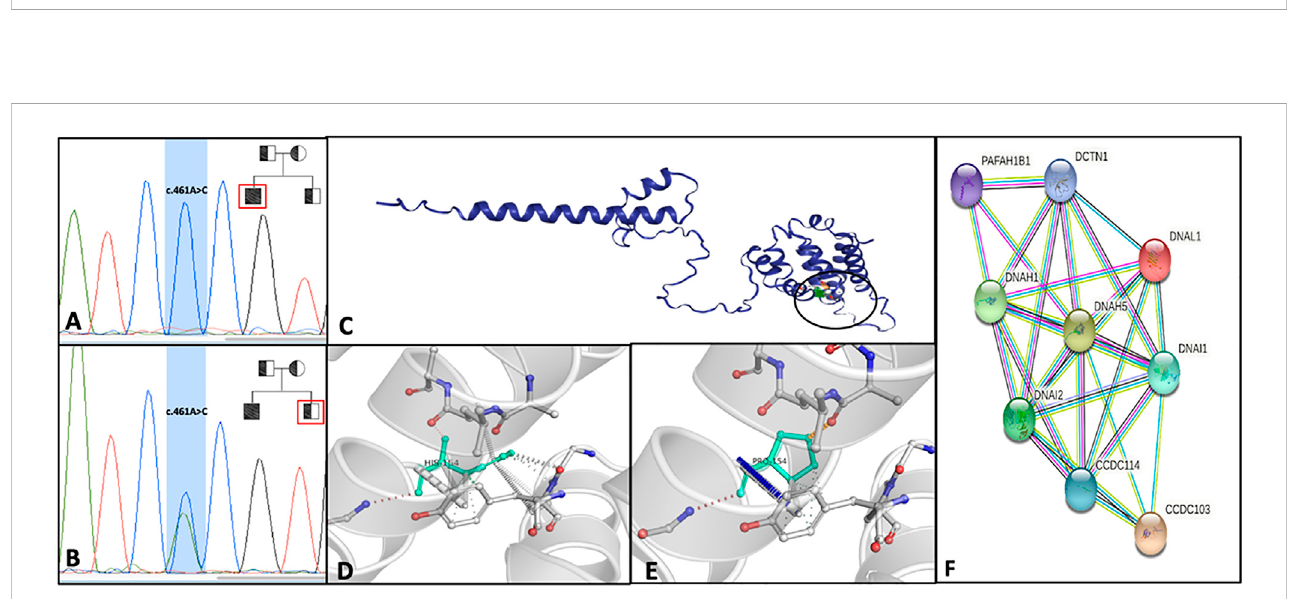
FIGURE 1 Electron microscopy micrographs of different section levels of the spermatozoa fl agellum with a focus on IDA and ODA (A – C) , spermatozoa samples treatedwithtannicacid (D,E), andnasalmucosasamples (G – L) .ScalebarforA-B-C100 nm,D-E-H-I50 nm,F500 nm,andG200 nm.Immuno fl uorescence (F) oftheejaculatedspermrevealedtheabsenceofbothDNAH1andDNAH5inthepatient(red)comparedtothenormalcontrol.Ananti-tubulinantibodywas used to mark the sperm axoneme (green), and DAPI was used to label the nuclei (blue).